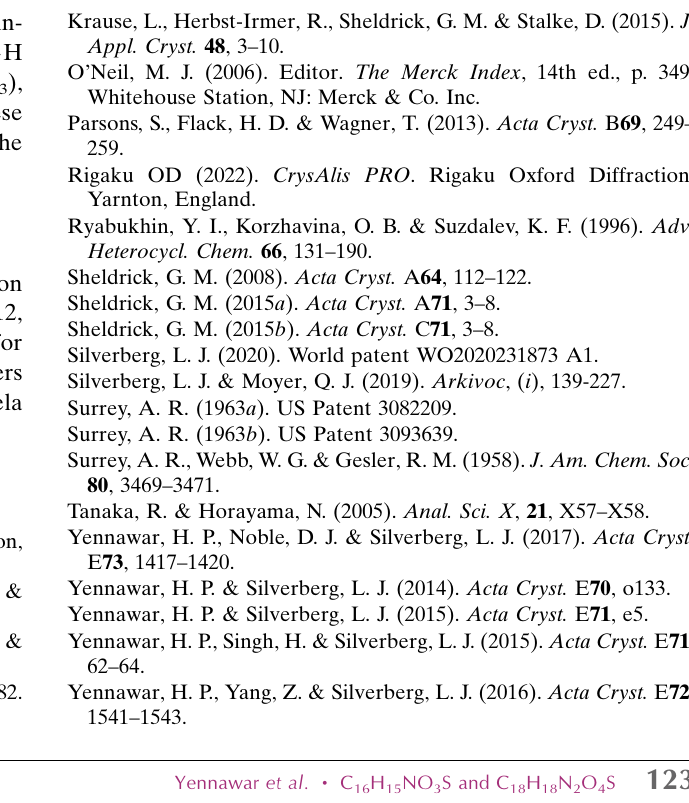
Crystal data Chemical